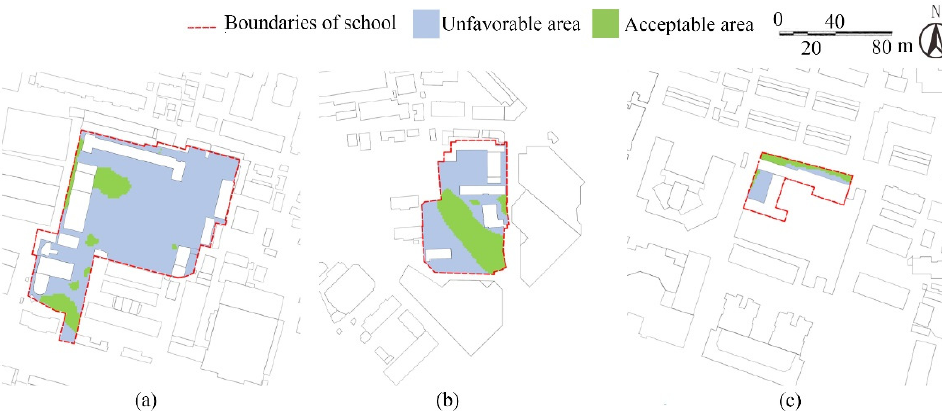
Figure 9. Distribution of wind comfort zones at the pedestrian level at three primary schools in summer in the 1990s: ( a ) Changjiang Road Primary School; ( b ) Chibi Road Primary School (Shanxi Road Campus); ( c ) Jianye Road Primary School.